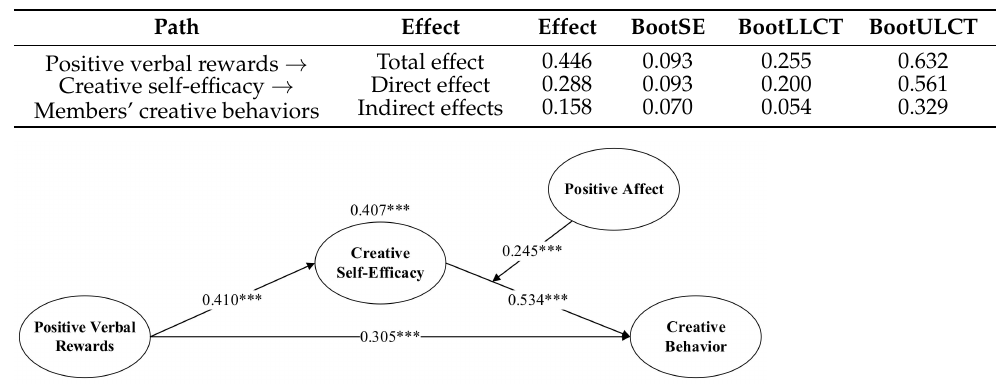
Table 5. Mediation effect test.